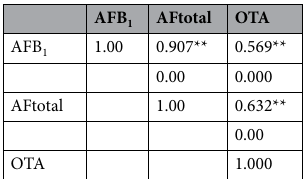
Table 6. Associations of mycotoxins (AFB 1 , AFtotal and OTA) in maize from Northern Region. **Correlation is significant at the 0.01 level (2-tailed).